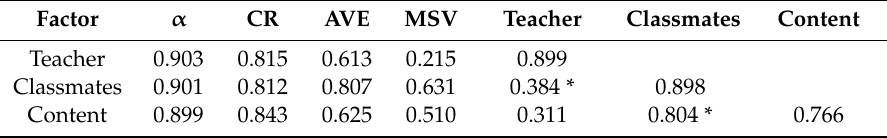
Table 3. Reliability and validity indices for the interactive